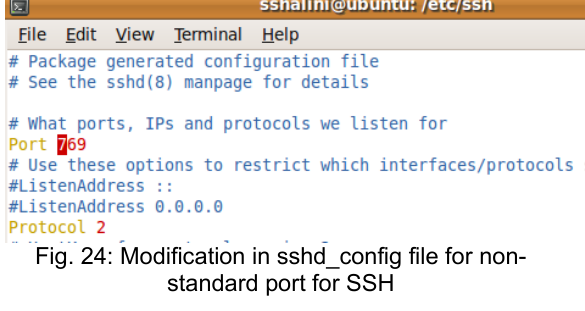
Fig. 23: OS details of a machine through zenmap scan